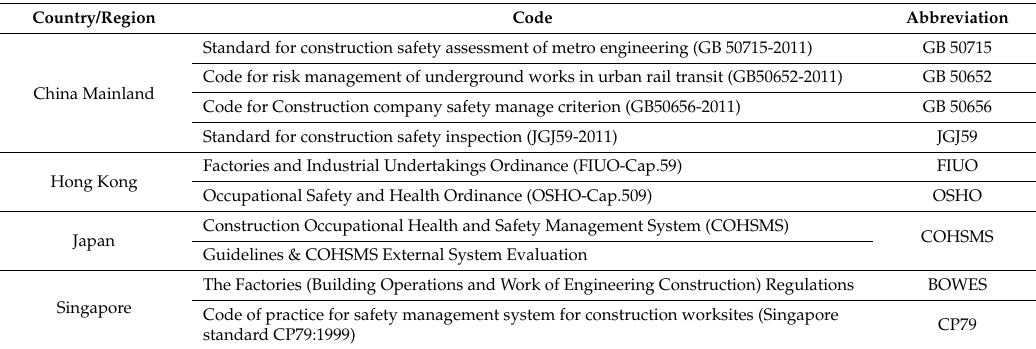
Table 1. Codes of construction safety management in different countries or